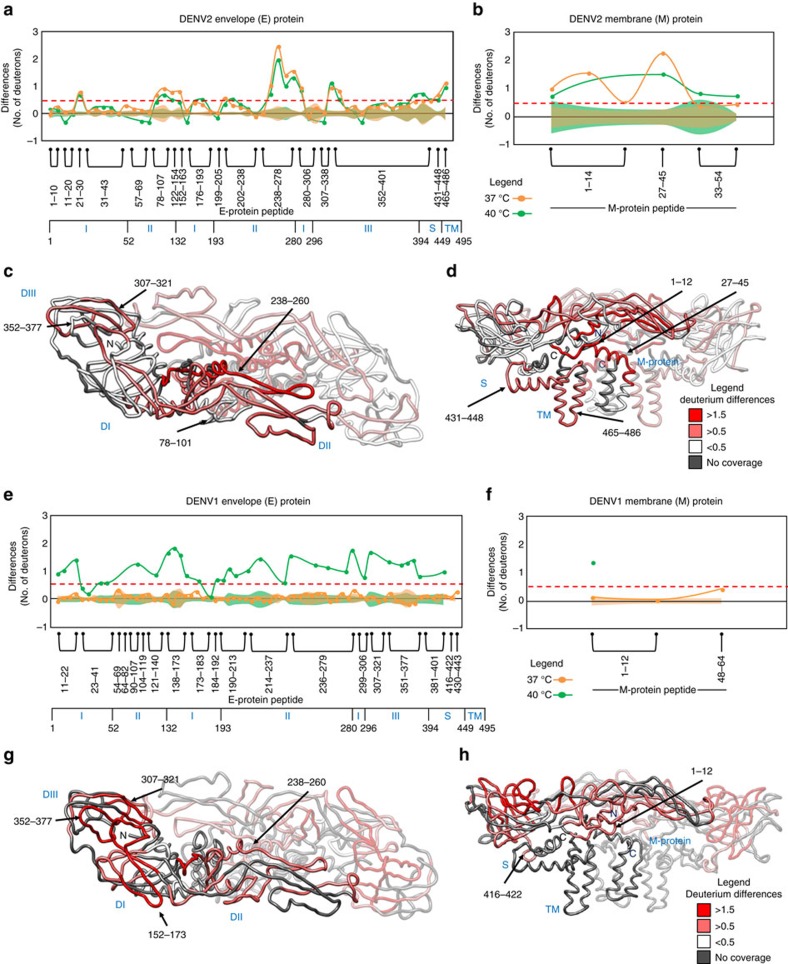
Non-uniform temperature-specific changes in DENV2 and DENV1 at 37 and 40 °C by HDXMS.Temperature-induced differences in deuterium exchange (t=1 min) in E-protein and M-protein from DENV2 (a,b, respectively) and DENV1 (e,f, respectively) between 28 and 37 °C (Orange line) and between 28 and 40 °C (Green line) are represented on a difference plot. Difference refers to the difference in average number of deuterons exchanged between two conditions. The difference plot displays the differences in exchange protein-wide where each dot represents a pepsin fragment peptide, listed from the N- to C-terminus. Y-axis-difference in deuterons, X-axis-pepsin fragment peptides. Differences in deuterium exchange above 0.5 D are considered significant (red dash line). Domain organisation of E-protein is indicated below the X-axis. S.e. for each peptide is shown as overlapping shaded regions along the X-axis and coloured according to the conditions in the difference plots. The individual s.e. in each condition is calculated as s.d.'s observed across all the HDXMS measurements (from at least three independent HDXMS experiments). The s.e. for a given peptide in the difference plot represents the sum of such single sigma s.d.'s of each of the two conditions being compared. Orthogonal views of the differences in deuterium exchange in E-protein peptides with temperature (37 °C in DENV2 (c,d) and 40 °C in DENV1 (g,h)) mapped onto the cryo-EM structure of E-M heterotetramer with one of the heterodimer rendered transparent for clarity. Regions with no peptide coverage are in grey.